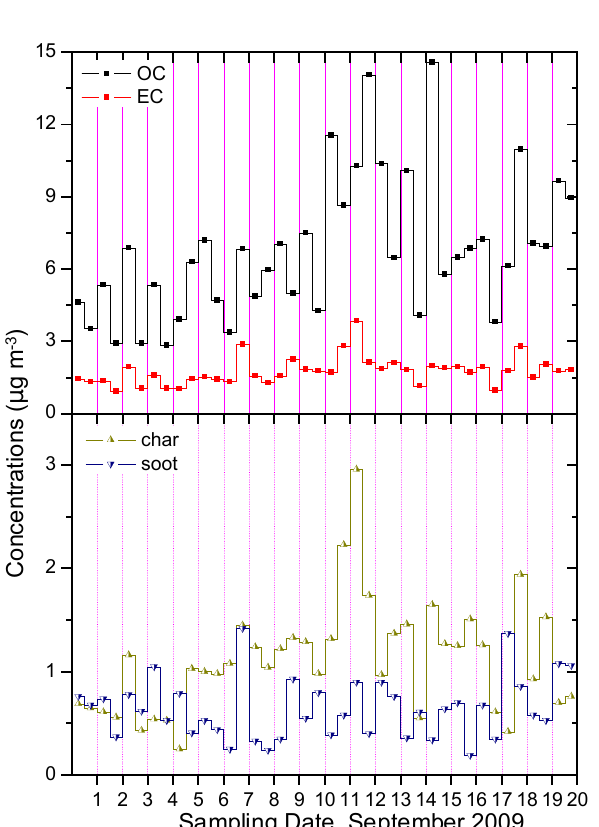
Fig. 1. Time series of OC, EC, char and soot for PM 2 . 5 in daytime and nighttime.